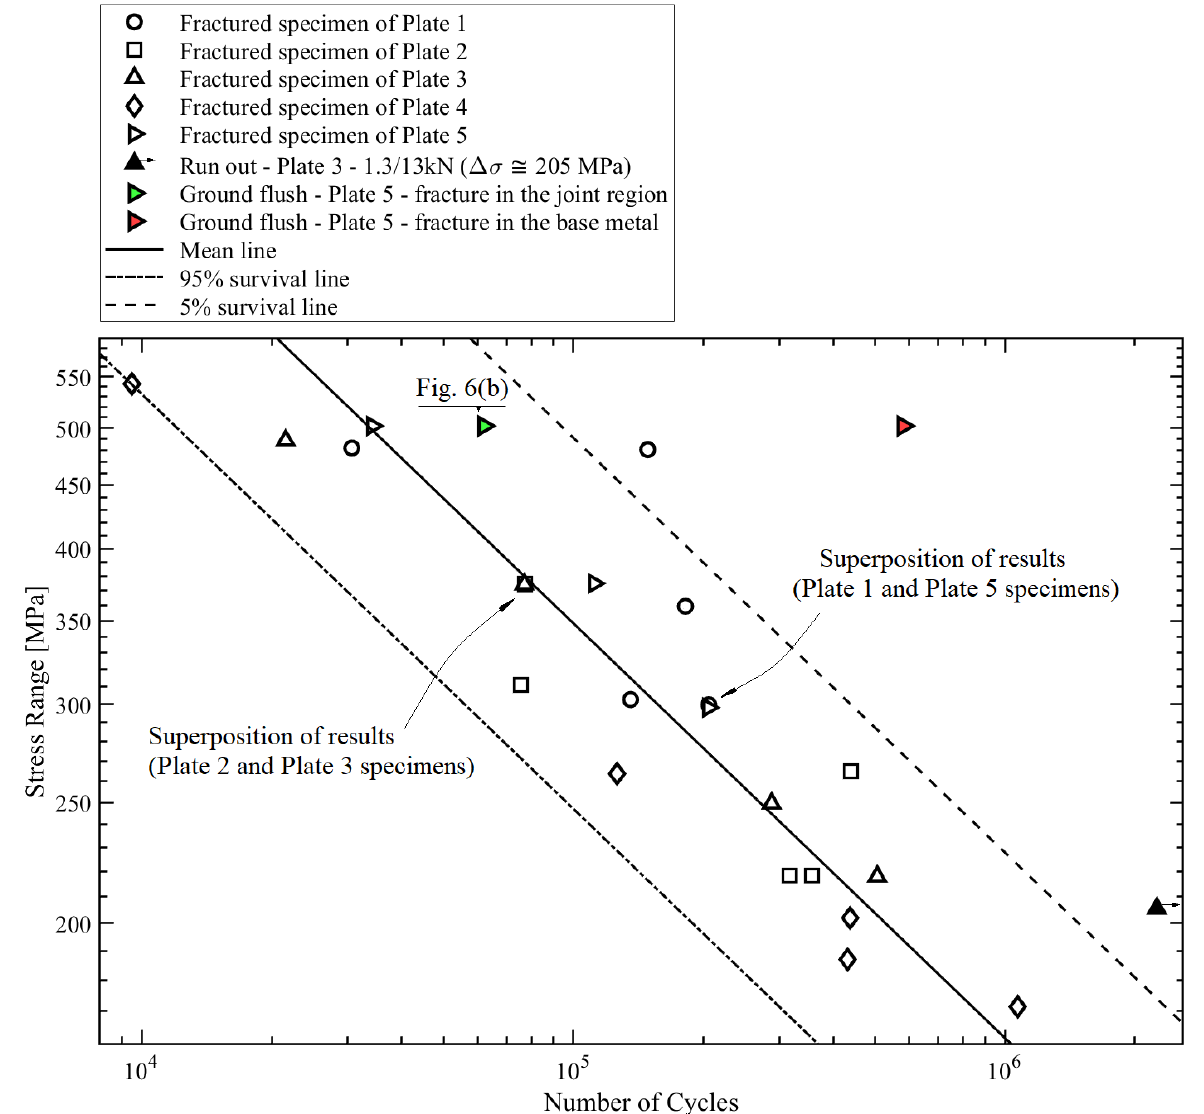
Figure 2. S – N diagram of laser-welded standard 22MnB5 steel. Figure 2. S–N diagram of laser-welded standard 22MnB5